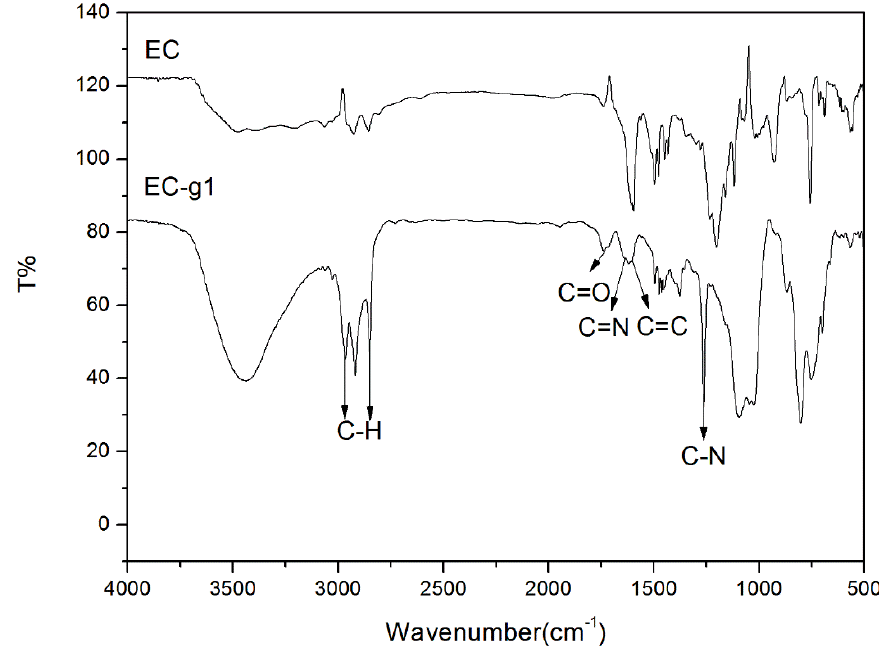
Figure 1. FT-IR spectrum of EC-g1 and EC.